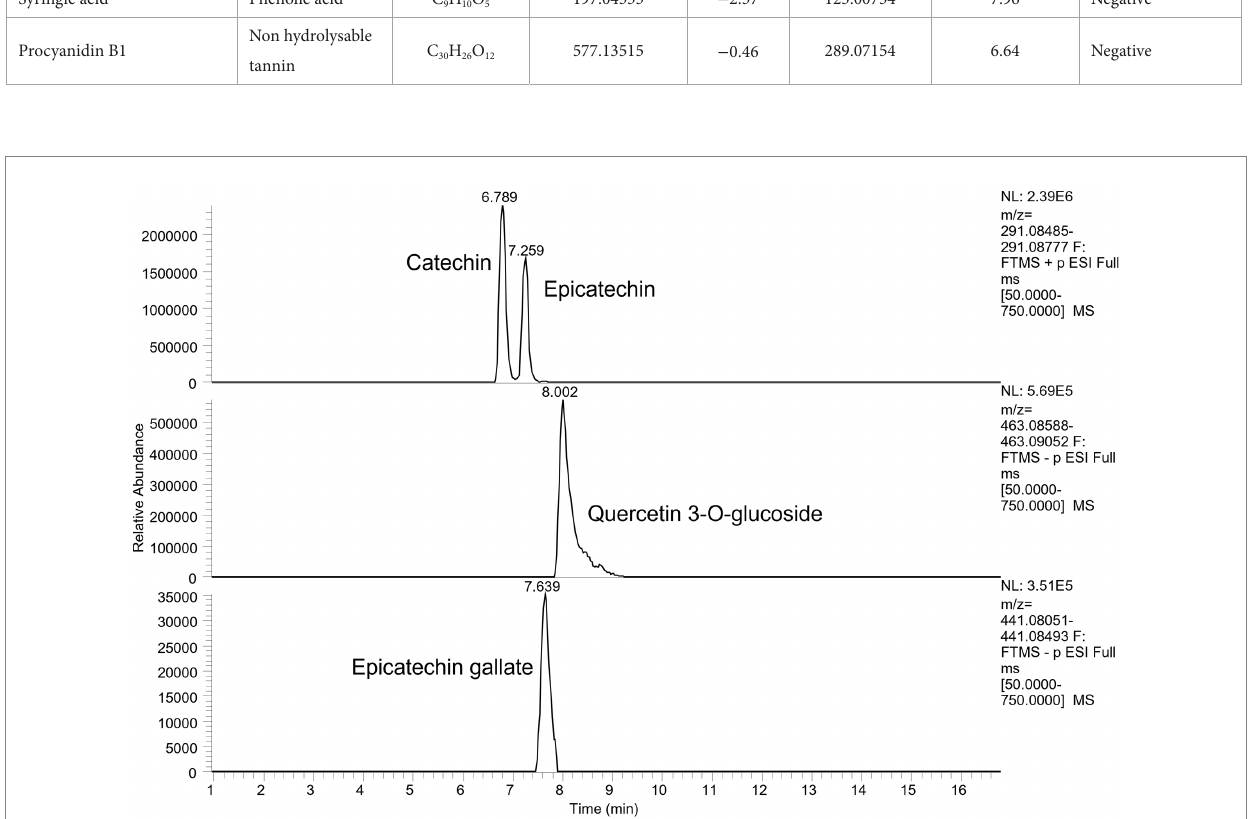
FIGURE 1 Example of an extracted ion chromatogram of the flavonols and flavanol catechin, epicatechin, quercetin 3-O-glucoside and epicatechin gallate in samples of